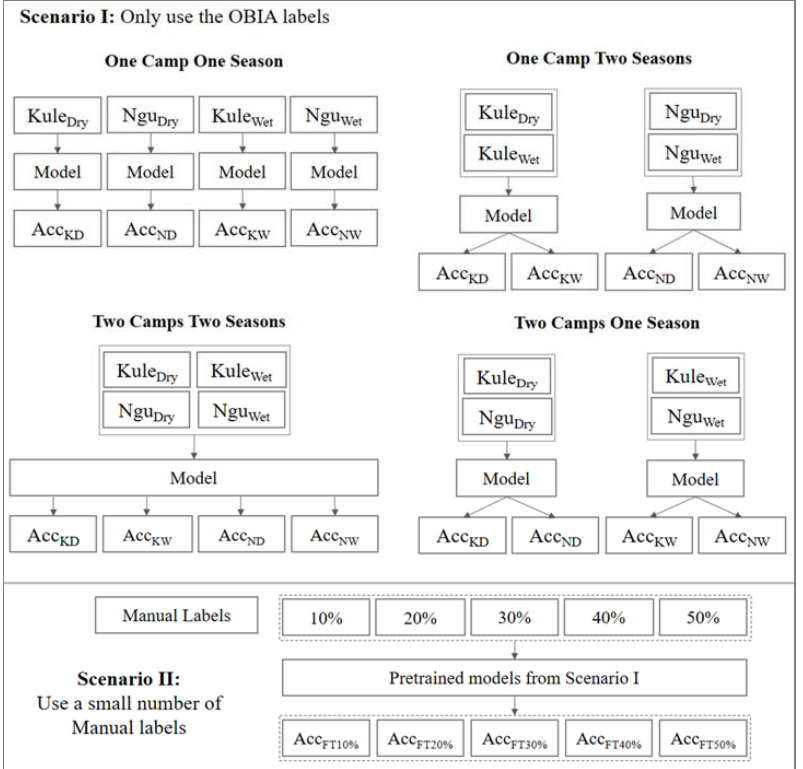
Figure 7. The designation of experiments for Scenario I and Scenario II. KuleDry means data from the Kule refugee camp during the dry season. AccKD means the accuracy of the model tested by data from KuleDry. Ngu denotes the Nguenyyiel refugee camp. Other abbreviations in Scenario I follow analogous rules. The FT in Scenario II denotes fine ‐ tuning.